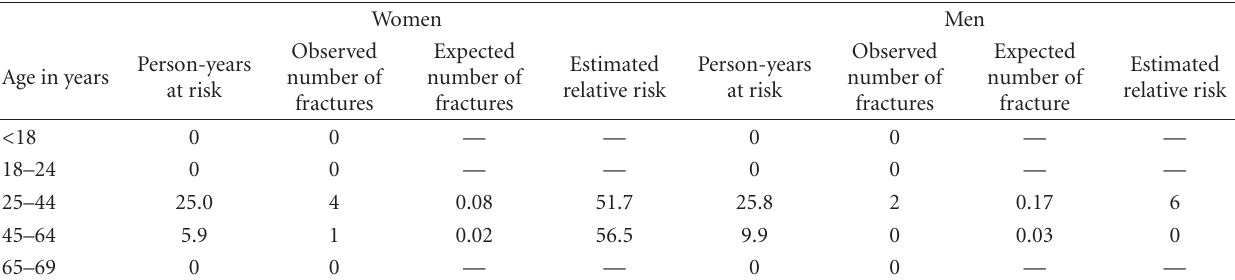
Table 7: Age- and gender-specific fracture incidence rates in pancreas transplant